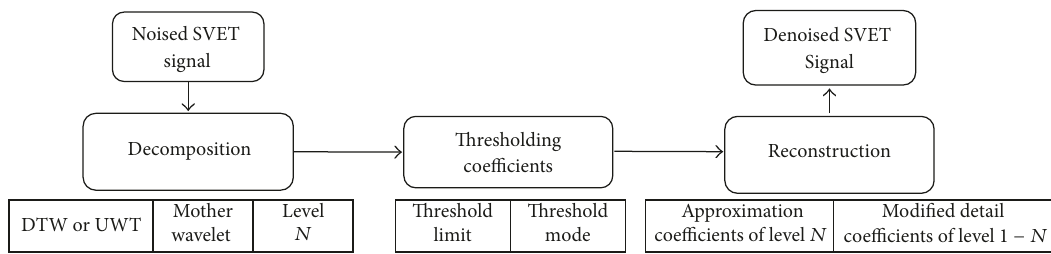
Figure 1: General thresholding